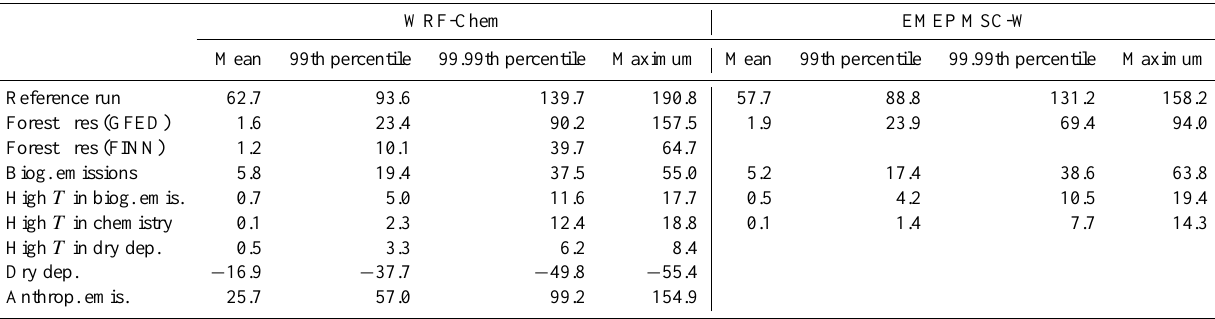
Table 5. Surface ozone mixing ratios (ppbv) in the reference run (1st row), and perturbations of surface O 3 due to various processes (rows 2–9). All values are based on model output of daily maximum surface O 3 in each gridbox the EM region for the summer 2007. Note that for dry deposition the percentiles and the maximum represent the highest negative